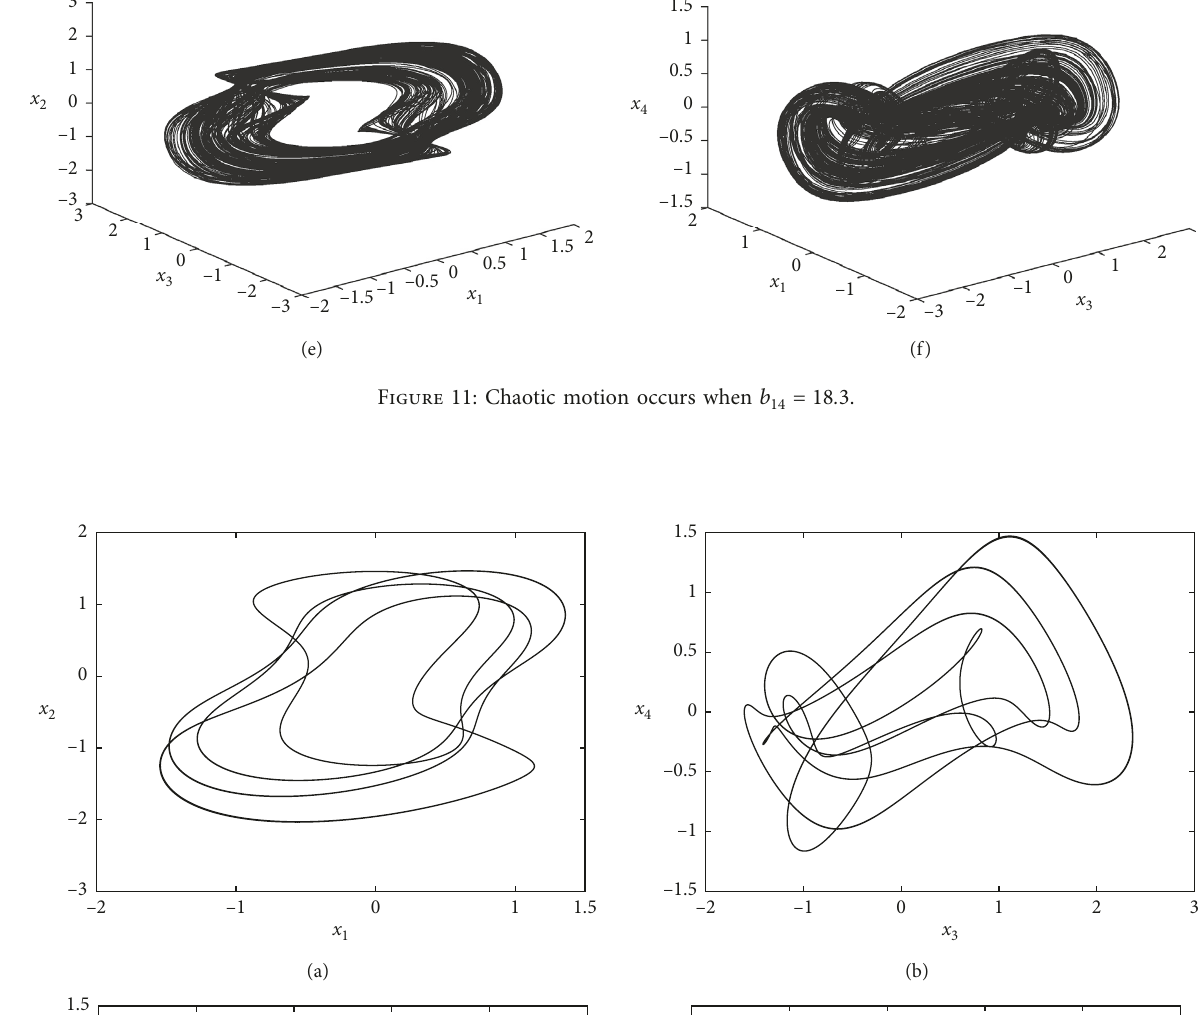
Figure 11: Chaotic motion occurs when b